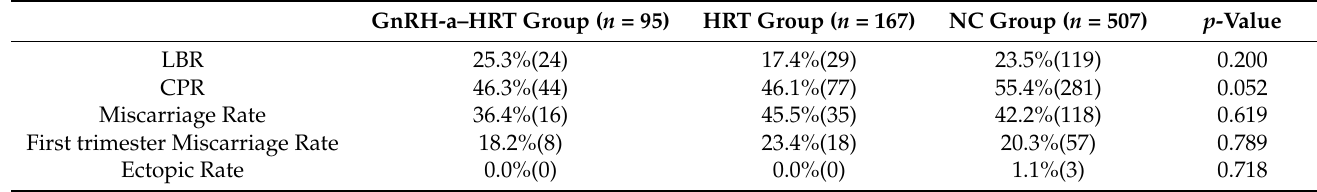
Table 2. Reproductive outcomes of three endometrial